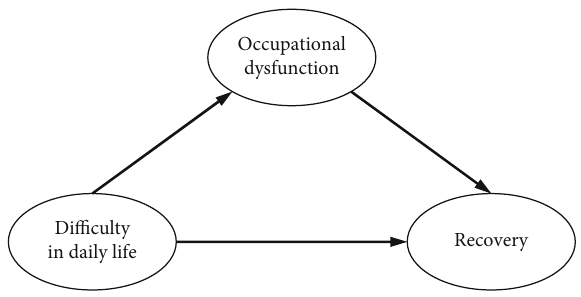
Figure 1: The hypothesis model. A hypothetical model of recovery process in severe and persistent mental illness (SPMI) includes the direct e ff ect of “ di ffi culties in daily life ” to “ recovery process ” without mediating variables, and the indirect e ff ect of “ di ffi culties in daily life ” to “ occupational dysfunction ” to “ recovery process ” via mediating